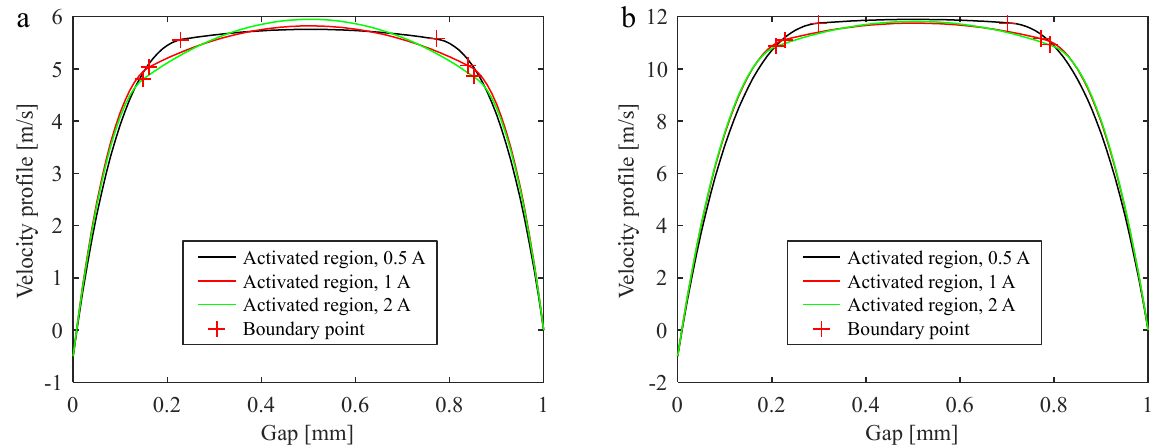
and 0 5 = . m/s v and 1 = m /s v are shown in Figure 21. When the vol- 0 0